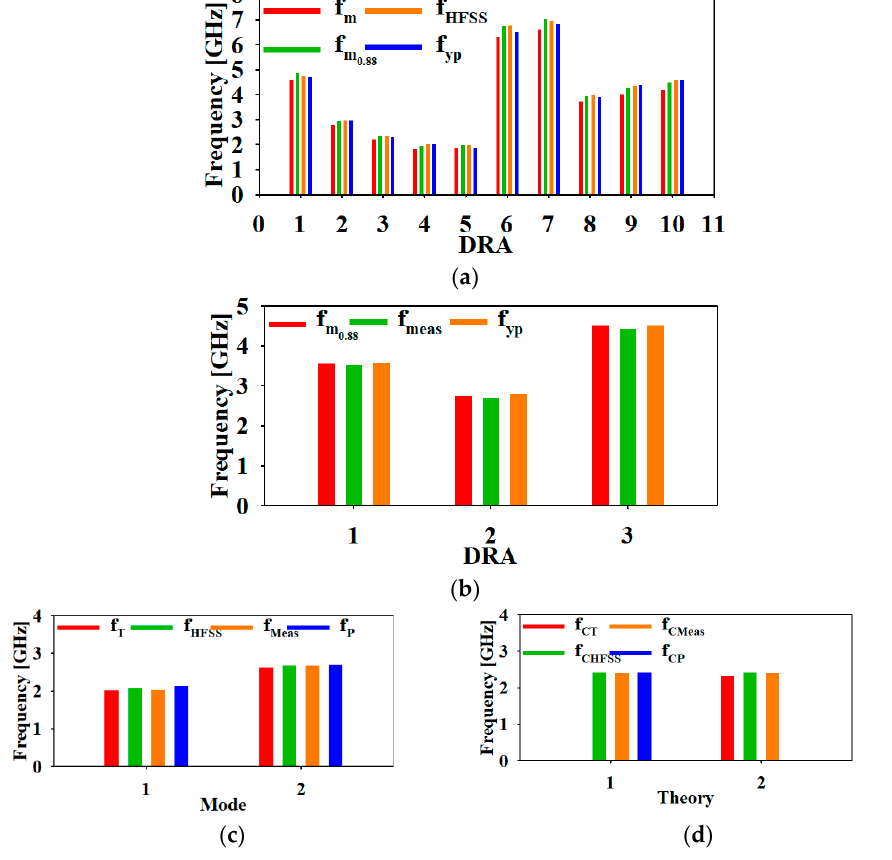
Figure 2. ( a , b ) Comparison of the mode matching technique with the proposed theory (refer to Tables 1 and 2). ( c , d ) Comparison of the transverse transmission technique with the proposed theory (refer to Tables 3 and 4). Table 1. Comparison of resonant frequencies with the mode matching theory and the simulated resonant frequencies of a